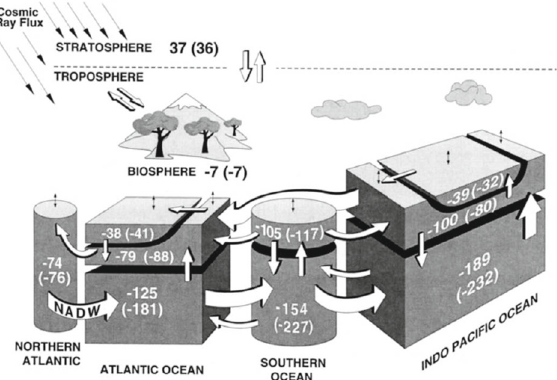
Fig.11 A12-boxmodelofthecarboncycle(BroekerandPeng1986;Siegenthaleretal.1980).The number on each individual box is the steady-state Δ 14 C of this particular reservoir expressed in per mil. Image reproduced by permission from Bard et al. (1997), copyright by